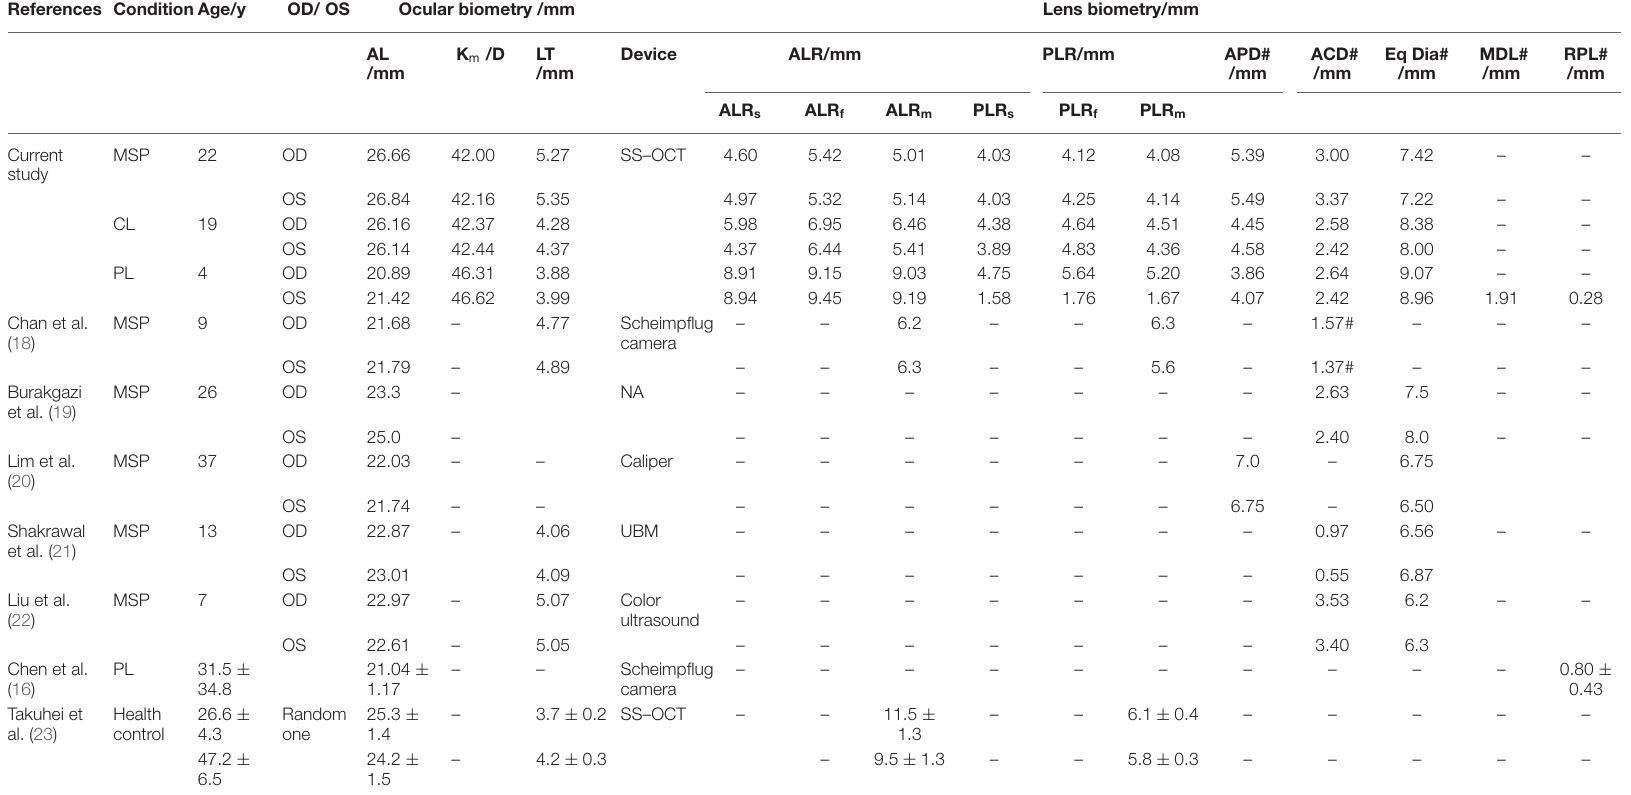
TABLE 1 | Ocular and lens biometric parameters in this study and existing literature. References Condition